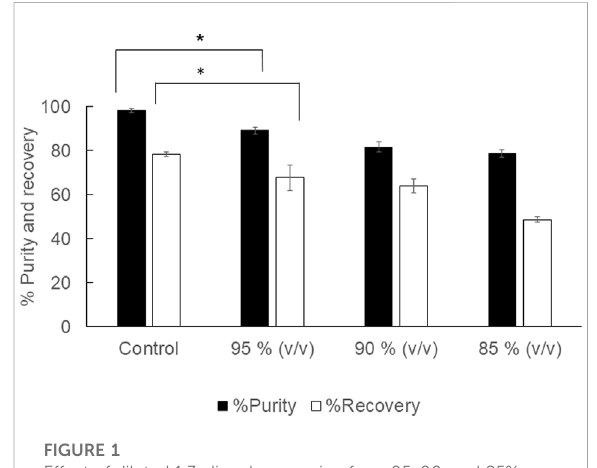
FIGURE 1 Effect of diluted 1,3-dioxolane varying from 95, 90, and 85% (v/v) on the % recovery and purity of the PHB extraction process. The control experiment was performed with undiluted 1,3- dioxolane. All the data are representative of the results of three independent experiments and are expressed as the mean values ± standard deviations (SDs). The asterisk indicates a signi fi cant difference ( p <